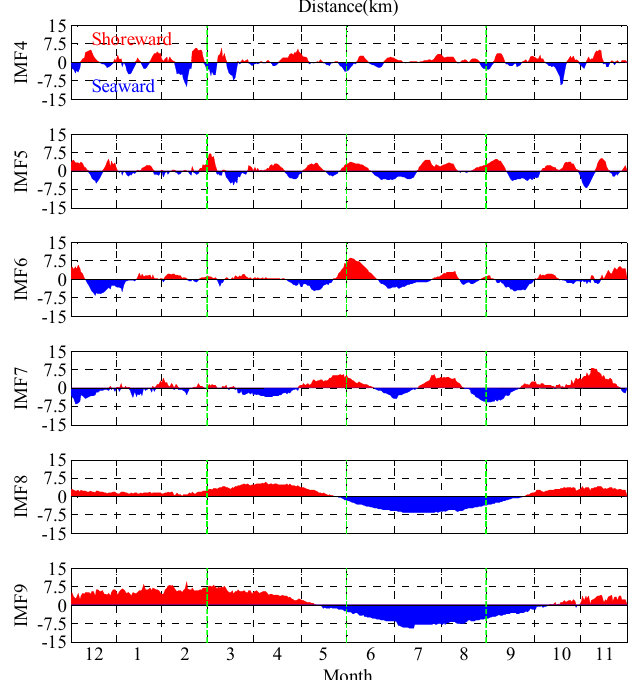
Figure 6. 24-year averaged daily series of IMF4-IMF9 along Transect A, with shoreward direction (northwestward) positive (red), seaward (southeastward) negative (blue). The series are divided into four seasons by the green dashed lines: winter (December, January and February), spring (March to May), summer (June to August), and autumn (September to November) .